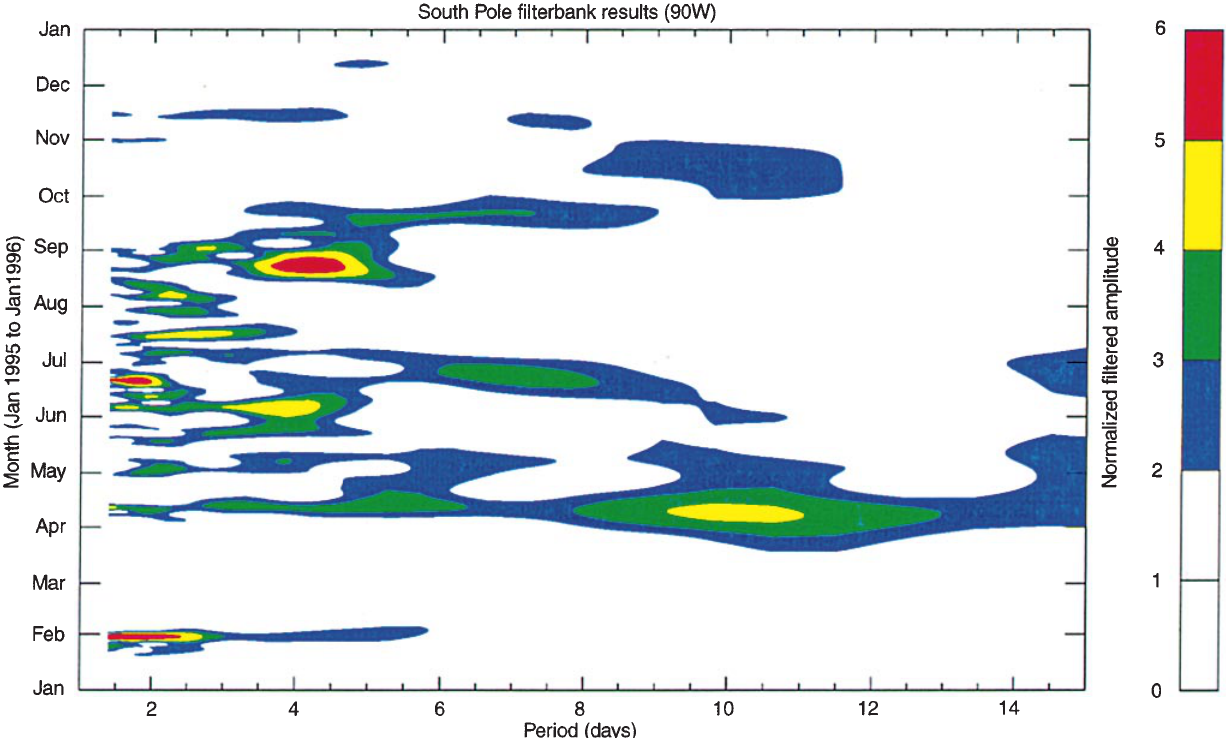
Fig. 9. The result of filtering the South Pole observations from the 90 (cid:14) west direction using a constant- Q filter bank. The color key is used to indicate statistical significance in terms of